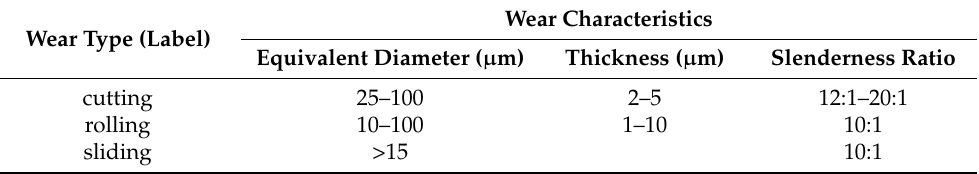
Table 3. Classification and label of wear particles under actual working conditions.